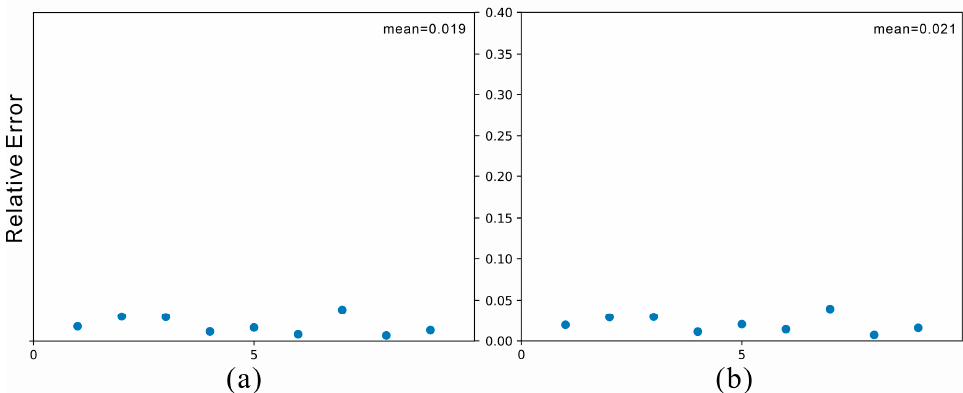
Figure 5. Relative error of each interpolation result with different methods: ( a ) Relative error of the results interpolated by OK. The mean is 1.9%; and ( b ) Relative error of the results interpolated by UK. The mean is 2.1%.